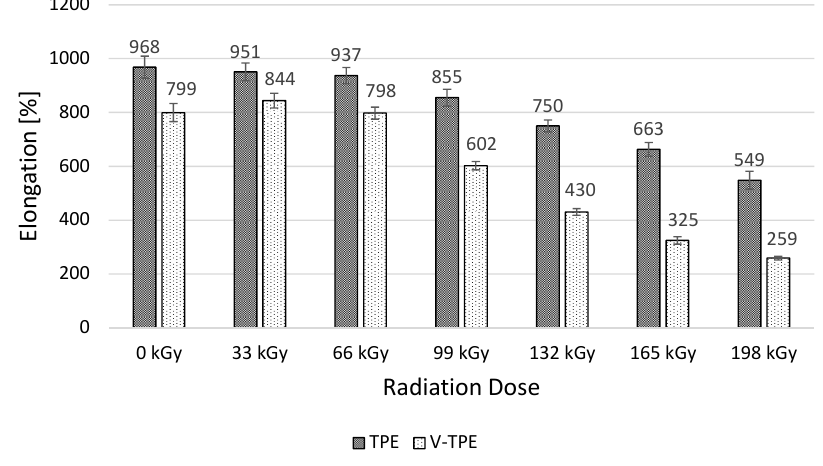
Figure 10. Elongation—TPE, V-TPE.